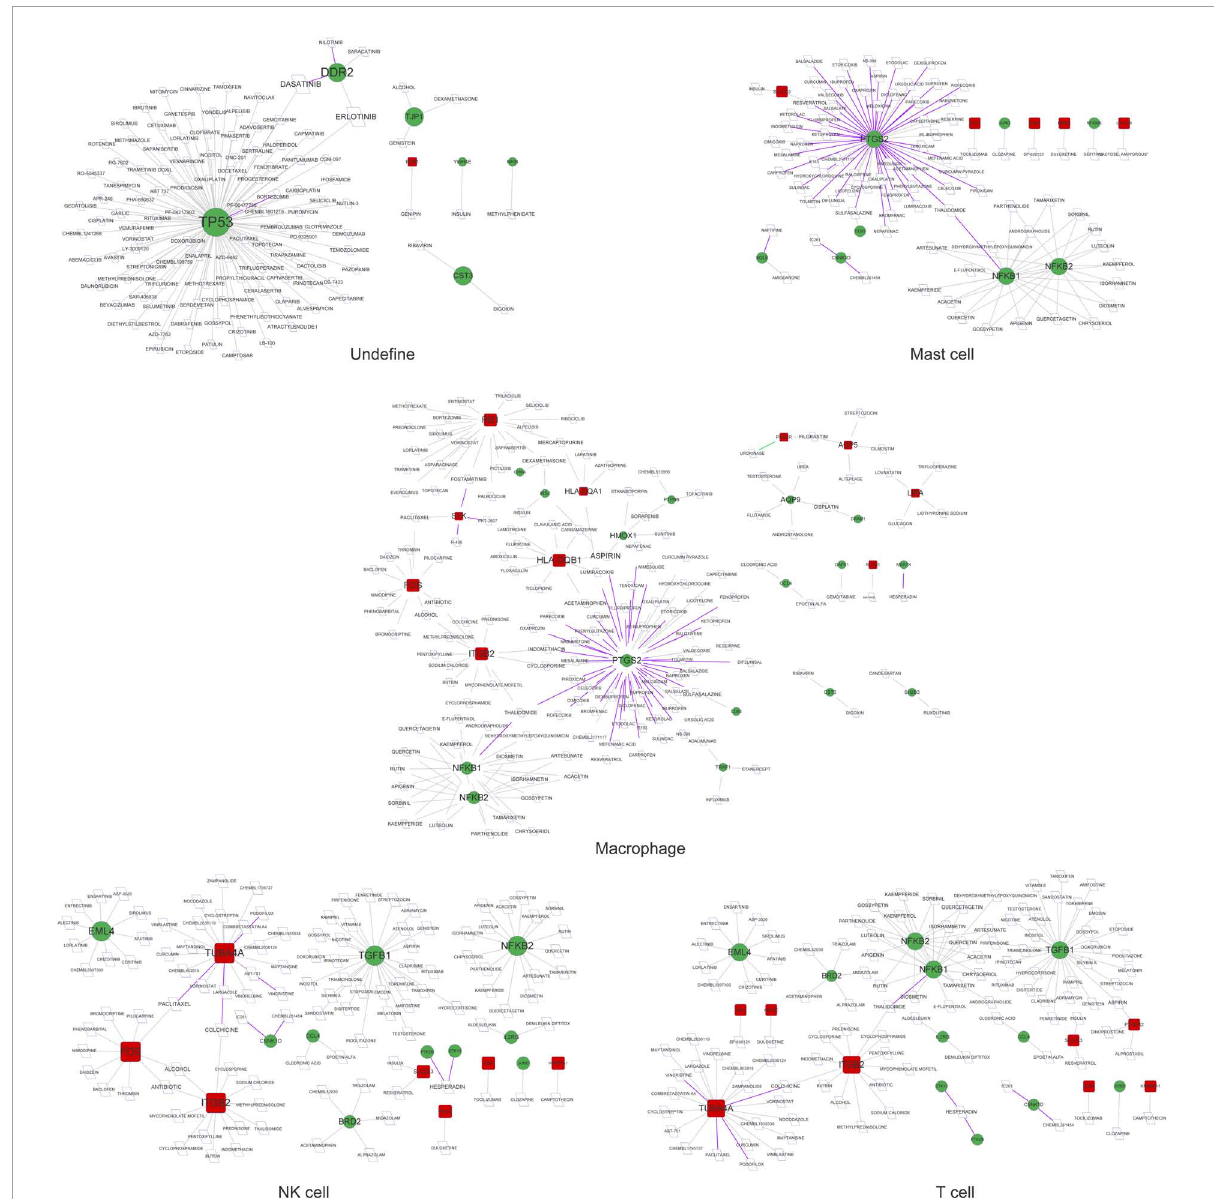
FIGURE5 The drug–gene network in undefined cells, mast cells, macrophages, NK cells, and T cells. Red squares represent upregulated mRNAs; green circles represent downregulated mRNAs; purple lines represent the drug as an antagonist or inhibitor; green lines represent the drug as a promoter or adjuvant; gray lines represent an unknown